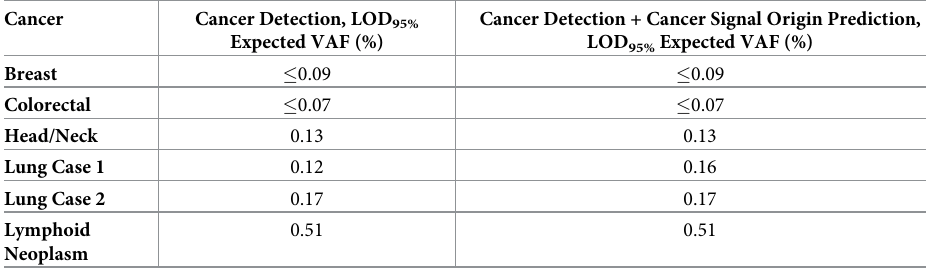
Table 2. LOD 95% with respect to expected VAF (%) for 5 cancers.